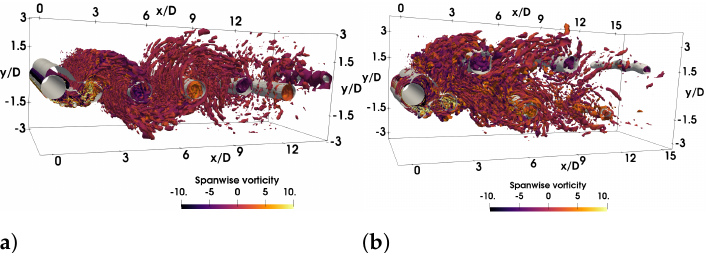
Figure 4. Wake topology. Instantaneous Q-isocontours Q = 3 coloured with the span-wise vorticity together with pressure isocontours at p = − 0.5 for ( a ) the initial branch U ∗ = 3 and ( b ) the super- upper branch U ∗ =